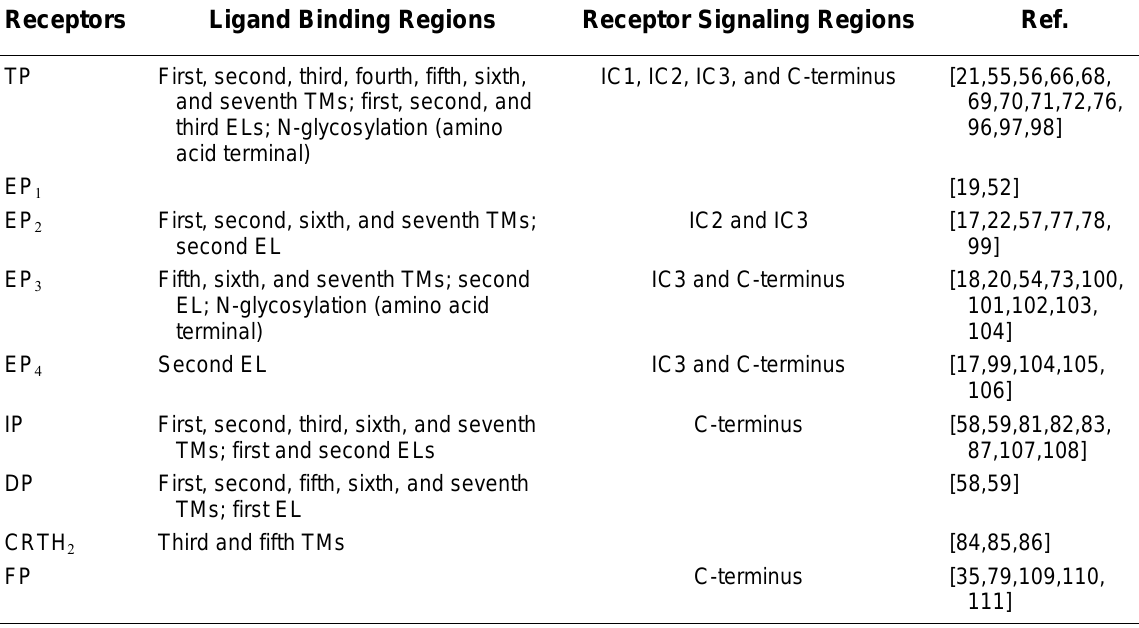
Prostanoid Receptors and Known Structurally Related Binding and Signaling Regions Receptors Ligand Binding Regions Receptor Signaling Regions